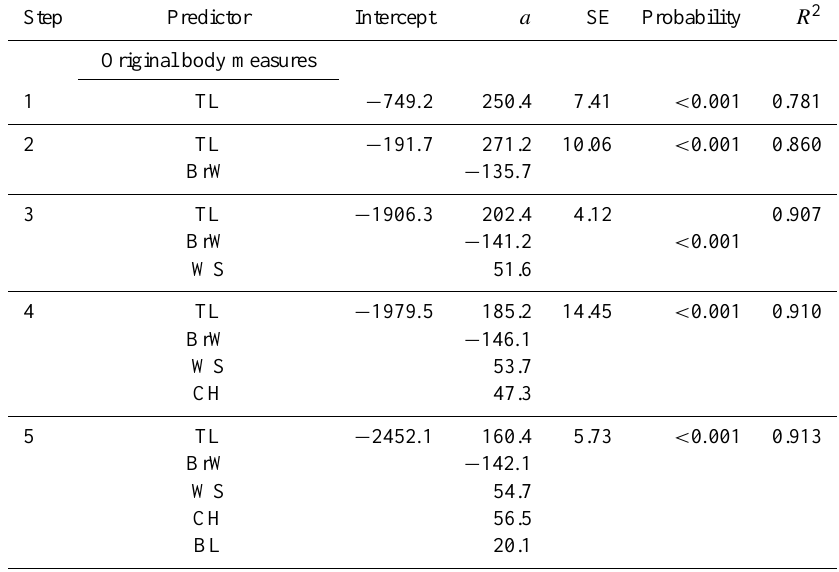
Table 7. Final stepwise equations for prediction of body weight for males. Step Predictor Intercept a SE